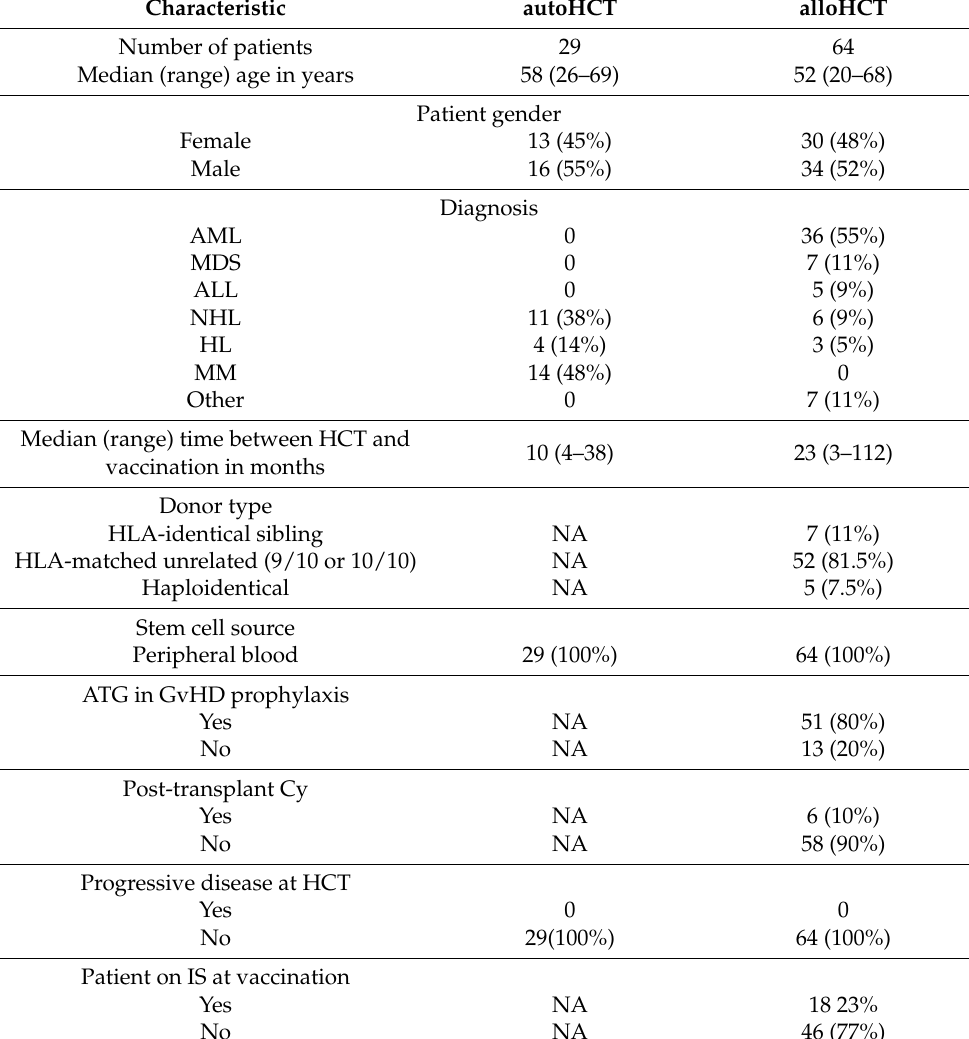
Table 2. Baseline patients’ characteristics at SARS-CoV-2